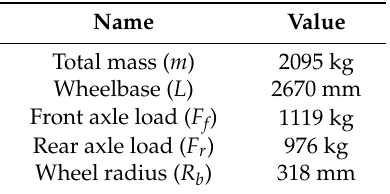
Table 1. Partial vehicle parameters of BYD